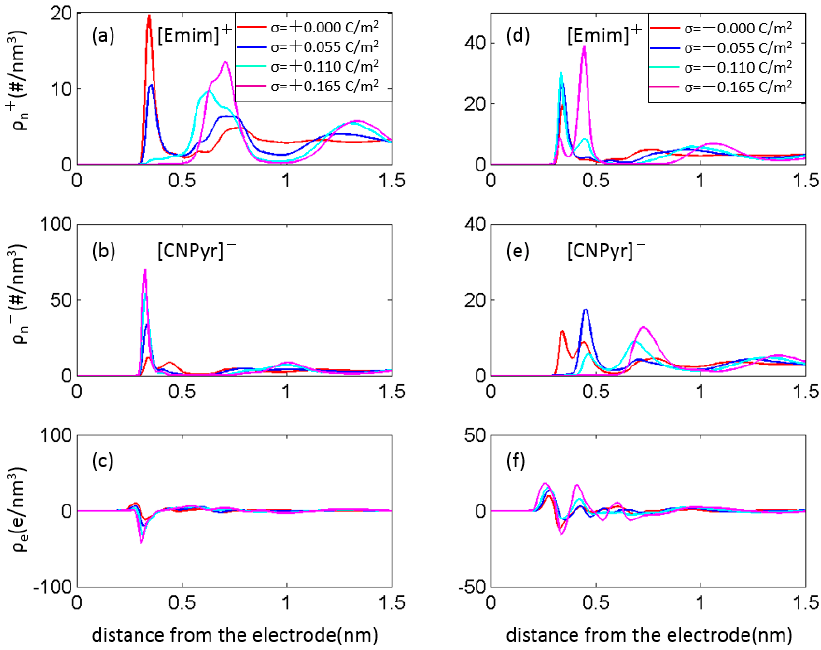
Figure 5. The number density distribution of cations and anions, and space charge density profiles of [Emim][CNPyr] near positively-charged electrodes ( a – c ) and negatively-charged electrodes ( d – f ).